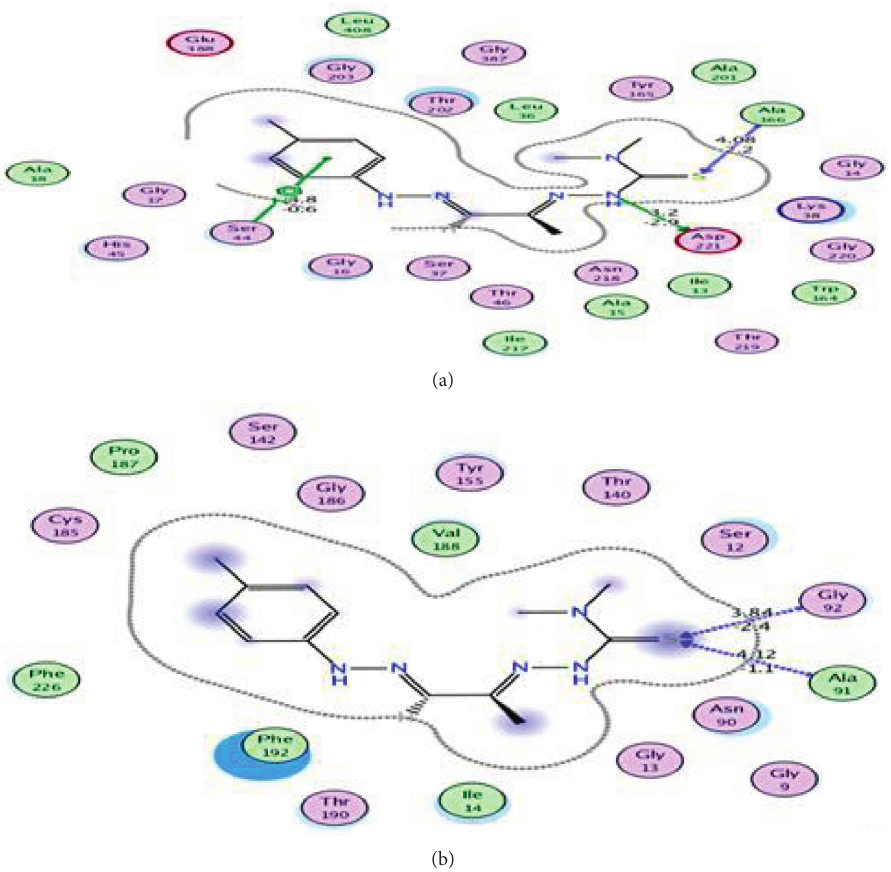
Figure 5: (a and b) 2D representations of the binding patterns of DMPTHP for inhibition to 1NEK protein of E. coli and 3HB5 protein of Homo sapiens , respectively.